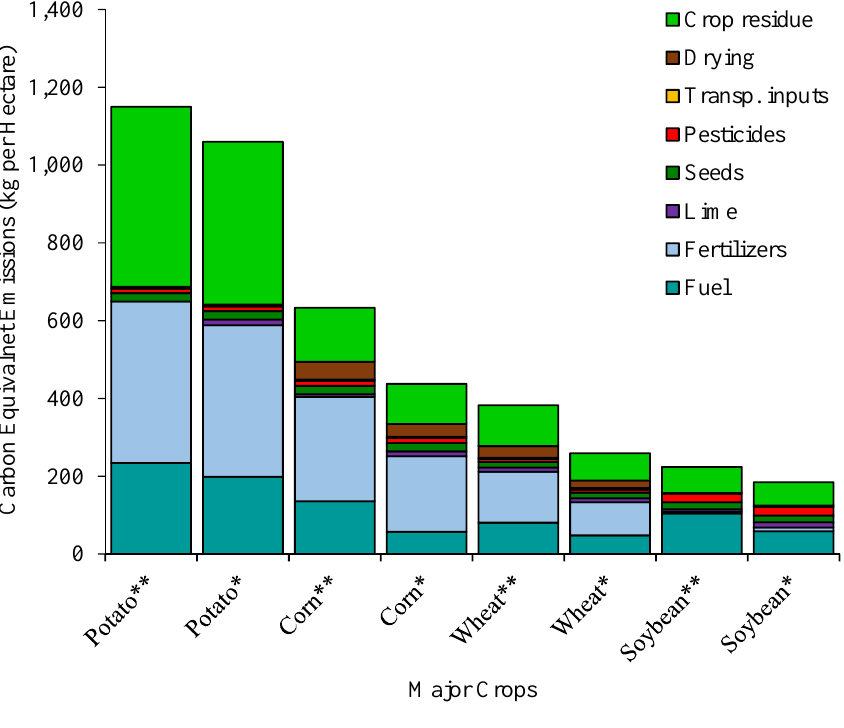
Figure 2. Mean carbon equivalent emissions for the major crops in the nine regions of the United States derived from crop budgets (2017) in the studied areas. ** = irrigated and * = non-irrigated crop systems.